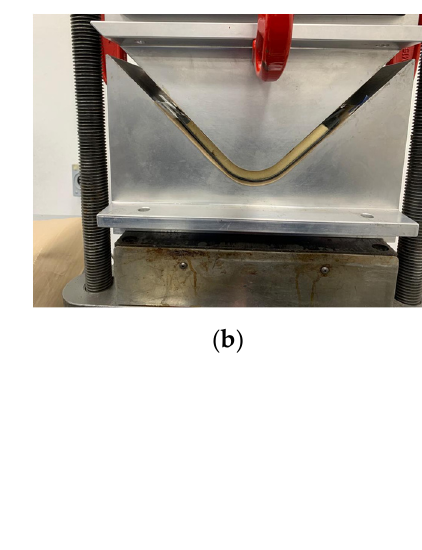
( c ) Figure 9. Pictures corresponding to the V ‐ shaped panels after bending tests of ( a ) GF/HC/GF, ( b ) GF/Foam/GF, and ( c ) GF/griding foam/GF. Table 2. Bending parameters. Composite Panel